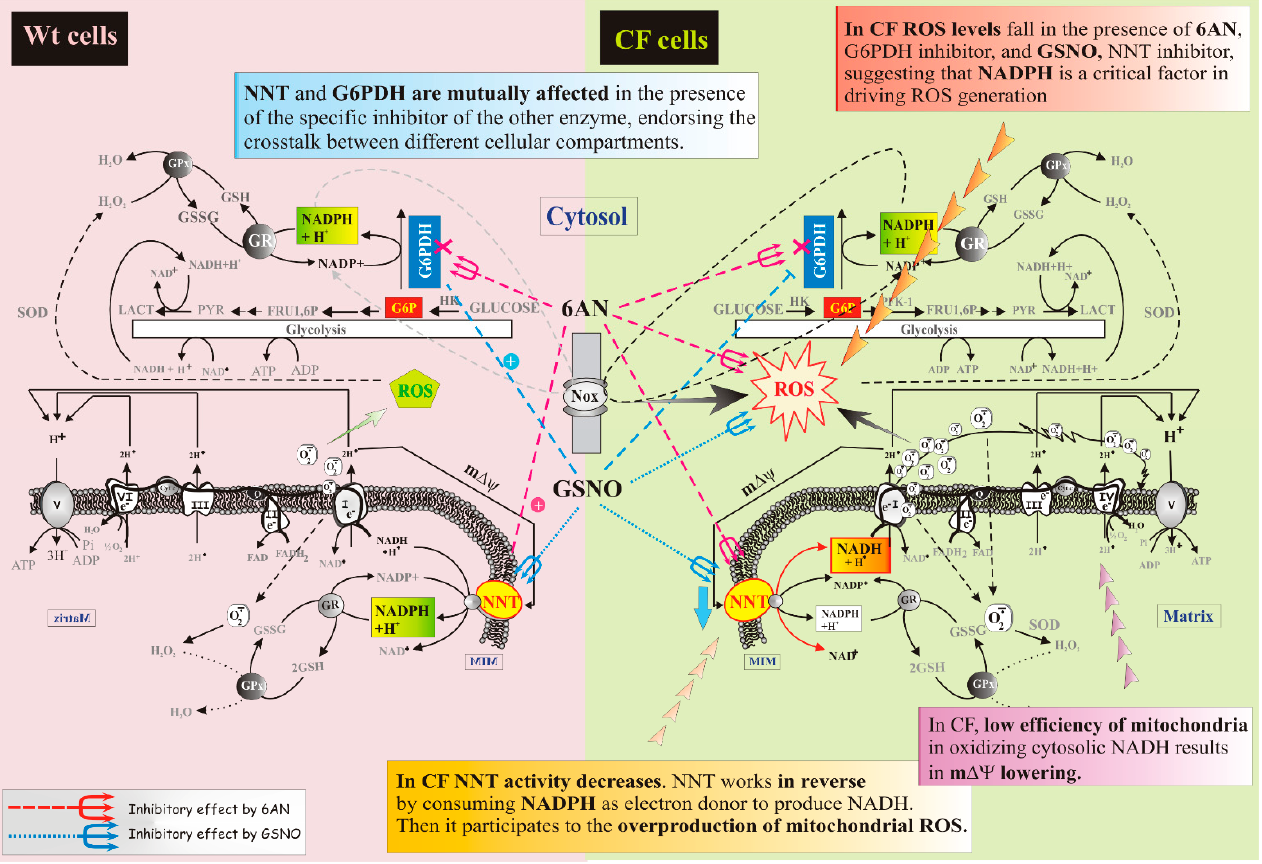
Figure 5. Representation of the cellular energy state. Comparison between Wt and CF conditions: different mode of action of NNT protein. Arrows are defined in the figure, bottom left.